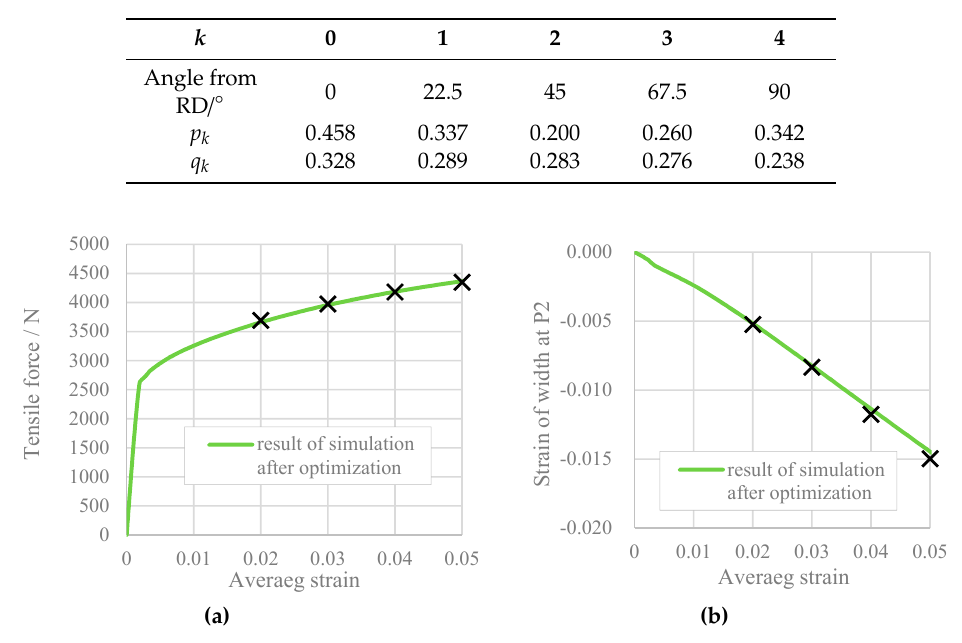
Figure 11. Comparisons between experiments and simulation result after optimization for the 0° direction. ( a ) Tensile force respect to average strain. ( b ) Strain of width at P2 respect to average strain.